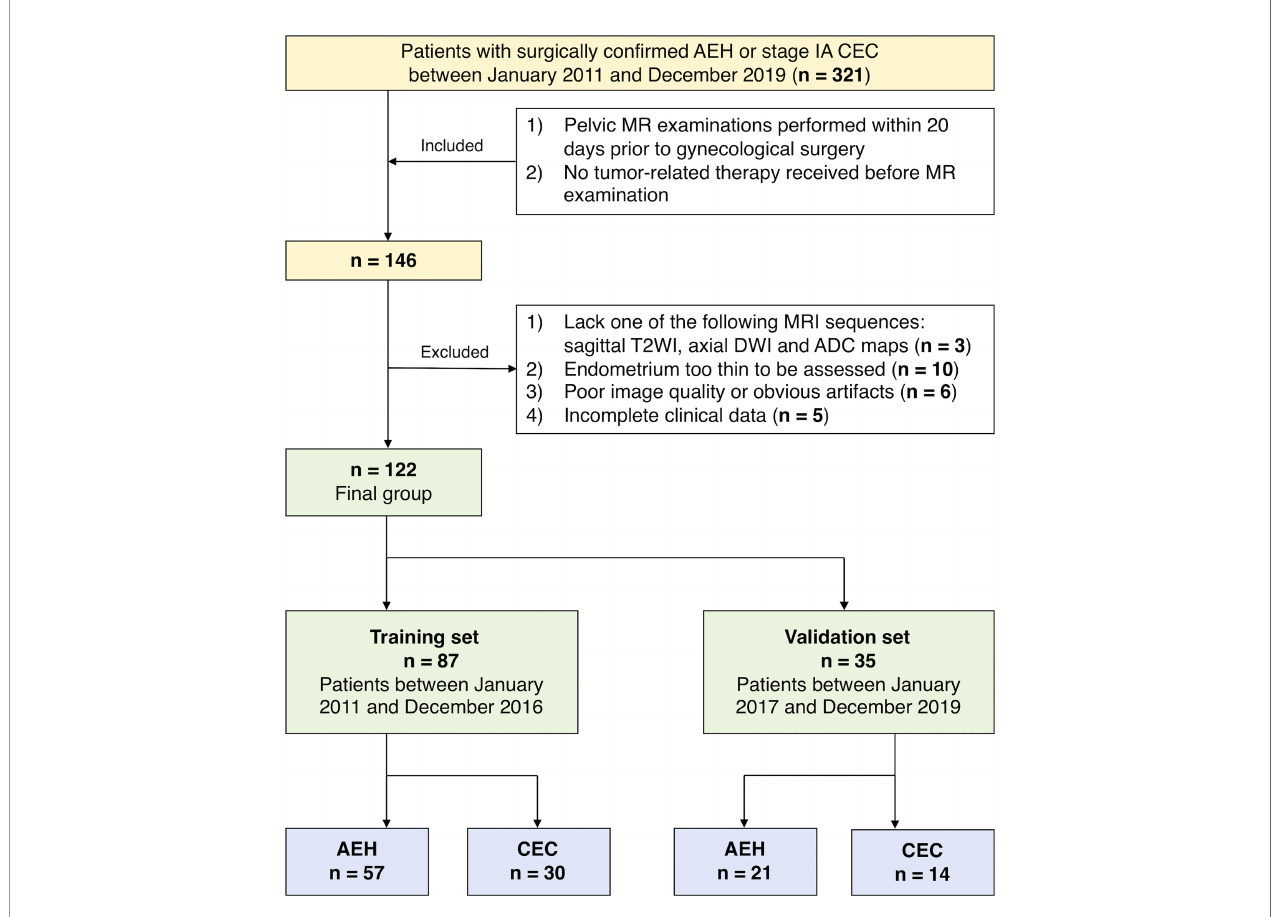
FIGURE 1 | Flowchart of patient enrollment in this